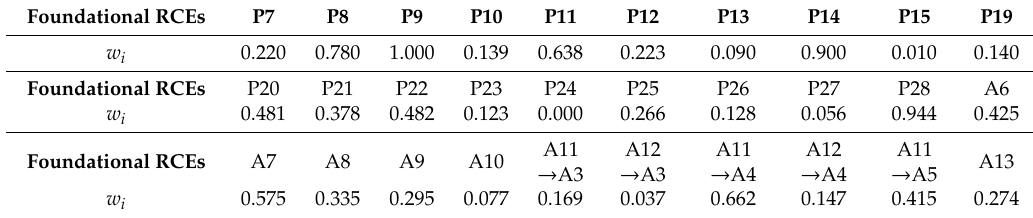
Table 3. The weight of the foundational RCEs of the coupling model V3: AR–PR.